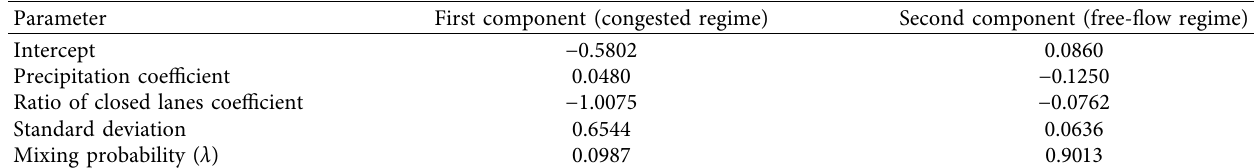
Table 2: Parameters’ estimates of the mixture of log-normal regression model.